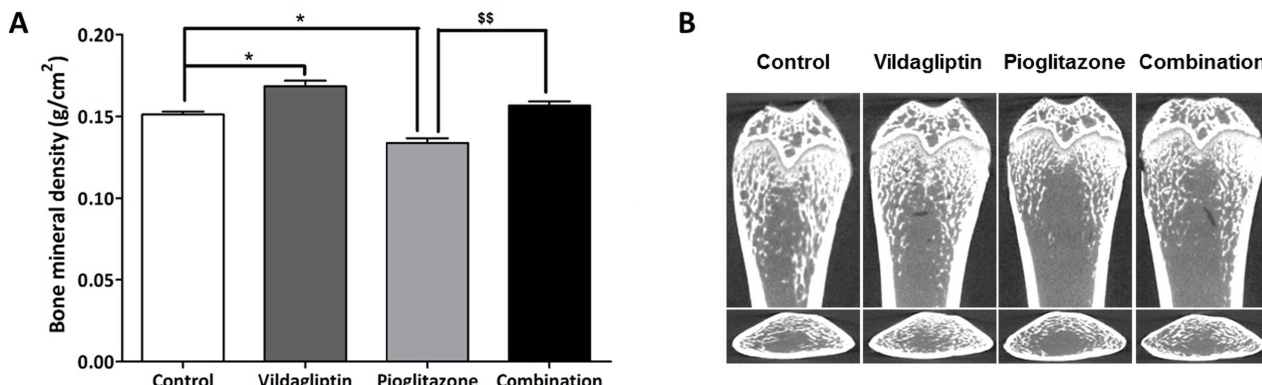
Fig 3. Bone mineral density and bone morphology after 5 weeks of treatment in ZDF rats. (A) Whole body bone mineraldensity (BMD) after treatments with control, vildagliptin (10mg/kg/day), pioglitazone (30 mg/kg/day), and combination (vidalgliptin10 mg/kg/day and pioglitazone30 mg/kg/day), (B) Micro-Computed Tomography (micro-CT) of femur after treatments with control, vildagliptin, pioglitazone,and combination. All data representedas Mean ± SD. * p < 0.05 comparedwith control group. $$ p < 0.01 comparedwith pioglitazone group.